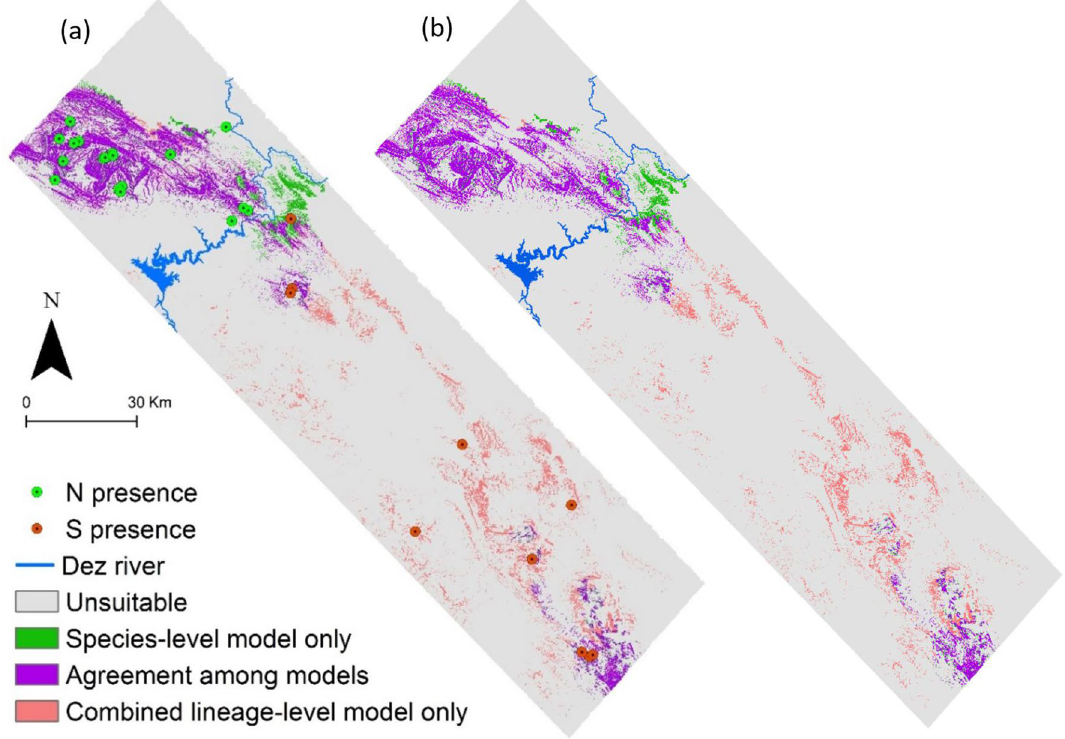
Figure 4. ( a ) Predicted geographic distribution of Neurergus kaiseri by species- and lineage-level models, derived from the combined landscape and local scale binary models. ( b ) Potential area of occupancy (pAOO) after eliminating non-spring areas at 30 m resolution. Discrepancies and agreements are depicted. The Dez River is depicted as a reference for lineages